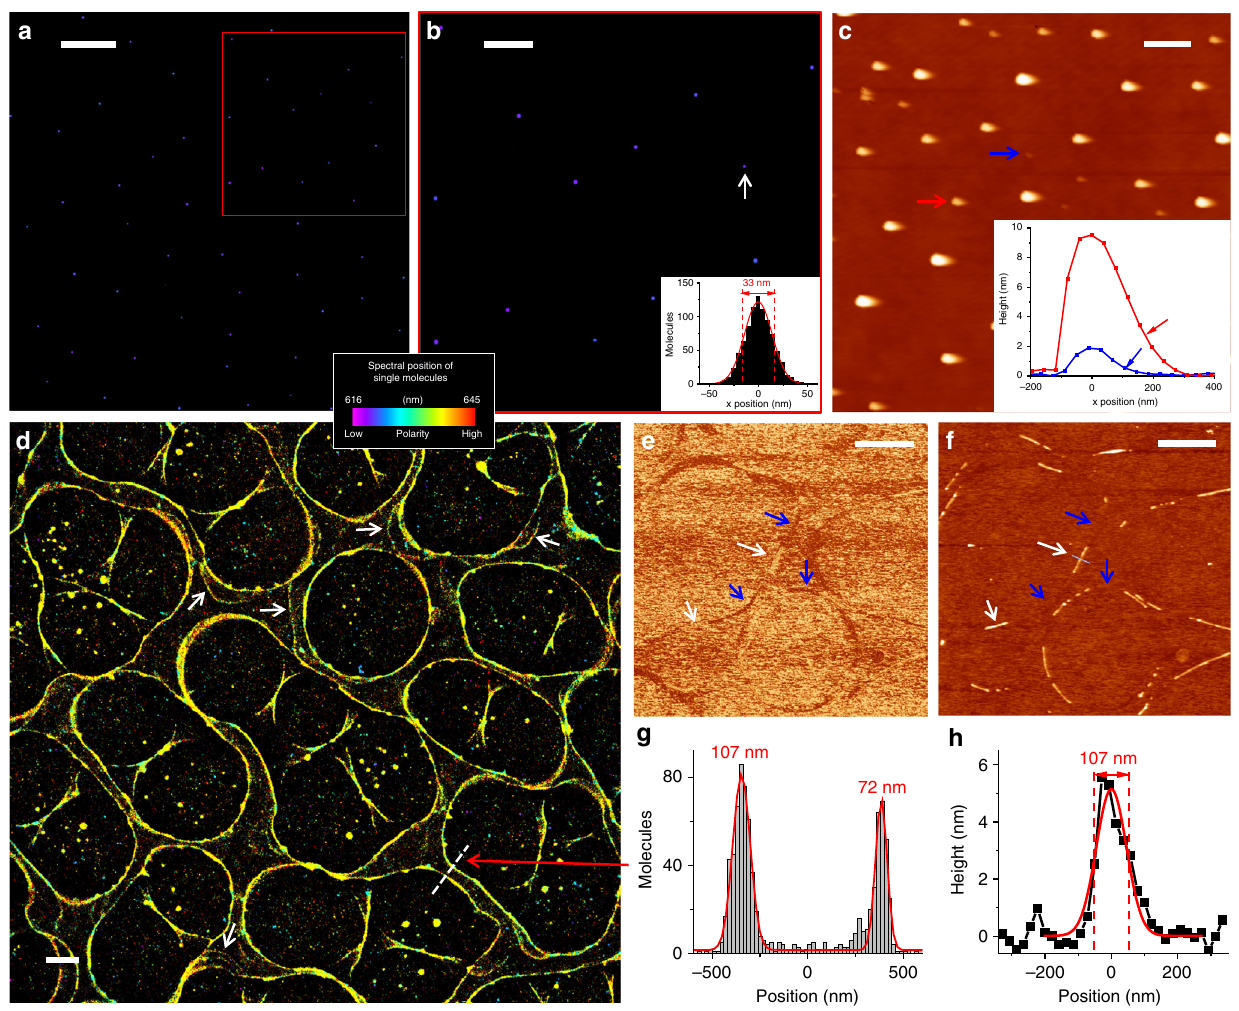
Fig. 2 Spectrally resolved super-resolution results of TCE and chloroform adlayers. a True-color SR-PAINT image of TCE adlayers, color-coded according to the spectral mean values of single Nile red molecules, hence an indicator of local polarity (color bar). Scale bar is 5 μ m. b Zoom-in of the red box in a . Inset: intensity pro fi le for the smallest droplet identi fi ed (white arrow). Gaussian fi t gives a FWHM width of 33 nm. Scale bar is 2 μ m. c Soft tapping-mode AFM image of TCE adlayers. Inset: height pro fi les of two droplets pointed to by the red and blue arrows. Arrows in the pro fi les point to asymmetry due to dragging. Scale bar is 1 μ m. d True-color SR-PAINT image of chloroform adlayers, on the same color/polarity scale as a and b . White arrows point to features between parallel edges. Scale bar is 2 μ m. e , f Soft tapping-mode AFM phase ( e ) and height ( f ) images of the same sample. White and blue arrows point to parts of adlayers that were only visualized in the height and phase images, respectively. Scale bars: 2 μ m. g Intensity pro fi le along the white dash line in d crossing two parallel edges. Gaussian fi ts give 107 and 72 nm for the FWHM widths of the two edge lines, respectively. h , Height pro fi le for the adlayer pointed to by the white arrow at the center of f . Gaussian fi t gives a FWHM width of 107 common organic solvents of contrasting polarity. Similar single- molecule spectra were observed for the same adlayer, whereas a notable redshift was observed for the more polar chloroform (Fig. 1d), consistent with the solvatochromic behavior of Nile red 31,32 . Statistics of the single-molecule fl uorescence intensity in the image channel gave asymmetric single-peak distributions (Fig. 1e) characteristic of typical STORM, PAINT, and other single-molecule experiments 28,33,34 , and the averaged counts were ~900 photons. By integrating the recorded positions and spectra of millions of single molecules over different frames, we mapped out both the morphology and polarity of the adlayers at the nanoscale.